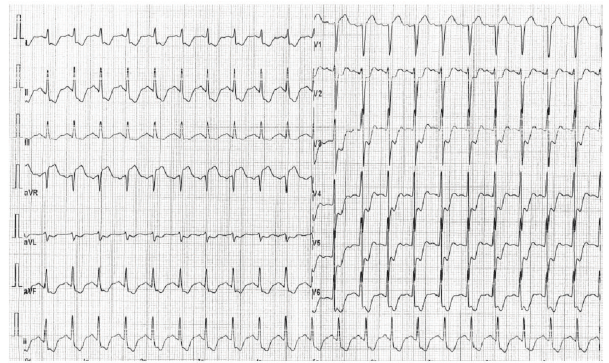
Figure 2: Explanation in the